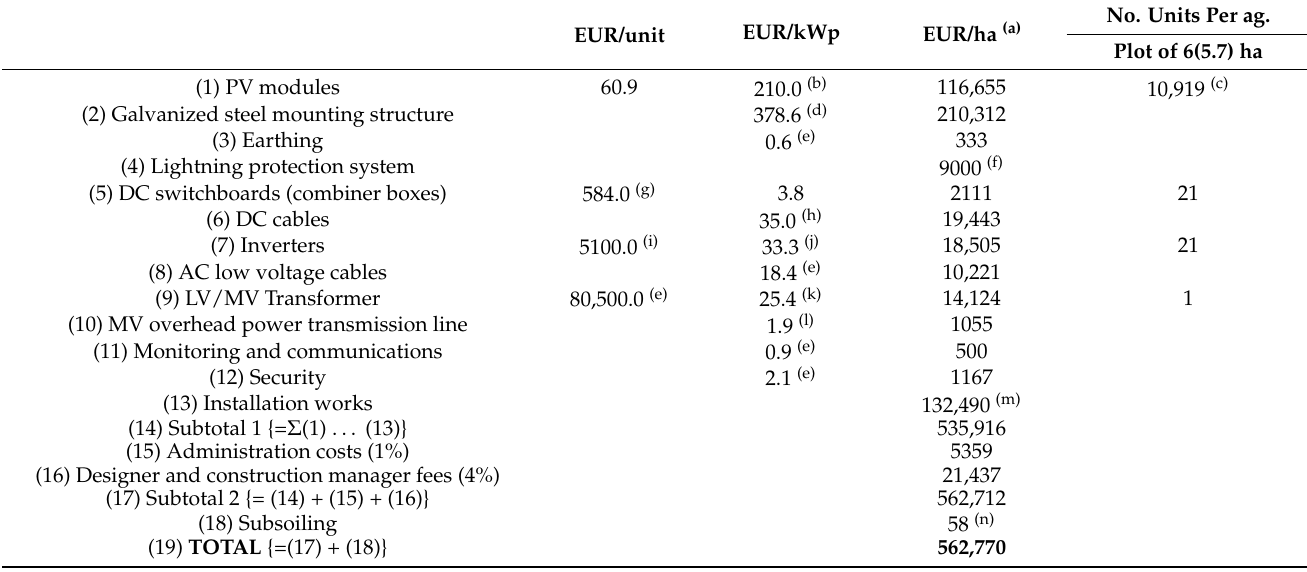
Table A2. APV system initial investment cost or capital expenditure, CapEx (the delayed CapEx item of inverters replace- ment incurred in year 14 is included in Table